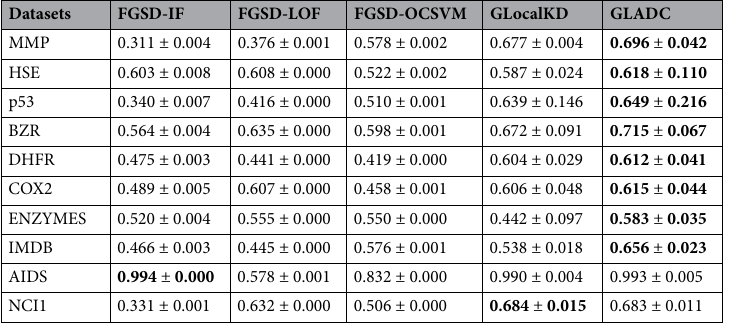
Table 2. AUC values (mean ± std) of graph level anomaly detection on ten datasets. Significant values are in bold.